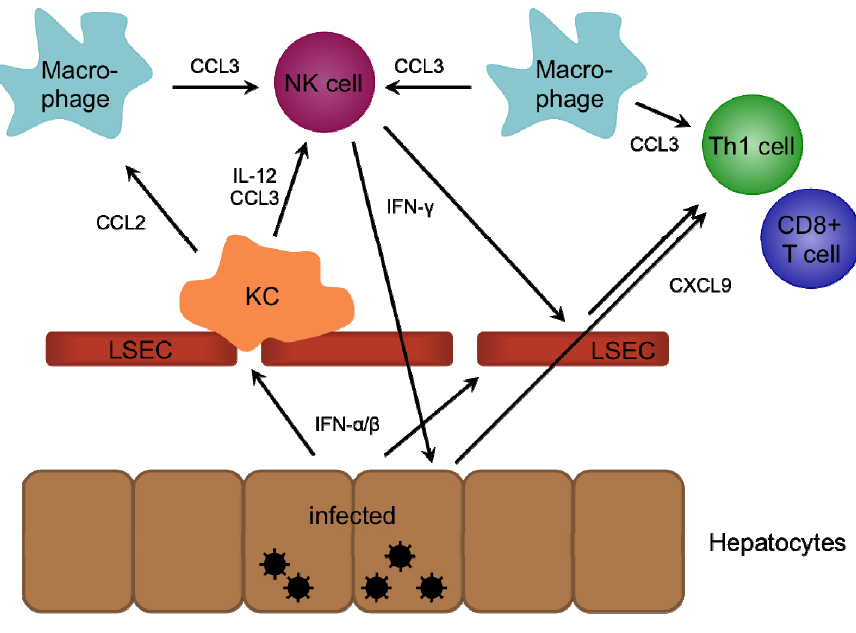
Figure 1. Recruitment of innate immune cells to the site of infection in the liver. Type I IFN released by hepatocytes upon pathogen recognition activates KCs, which secrete CCL2 and IL-12. CCL2 recruits macrophages, the main source of CCL3. NK cells recruited by CCL3 and activated by IL-12 release IFN- γ , that induces secretion of CXCL9 by LSECs and hepatocytes. CXCL9 and CCL3 attract Th1 and CD8+ T cells to the site of infection. DCs (not shown) are recruited by their CCR1/5 receptor and secrete amongst others CCL4 and CCL5. Neutrophils (not shown) are recruited by IL-1 or TNF- α -induced CXCL8 secretion from, e.g., KCs and enhance immune cell recruitment by secretion of CCL2, CXCL8, CXCL9 and